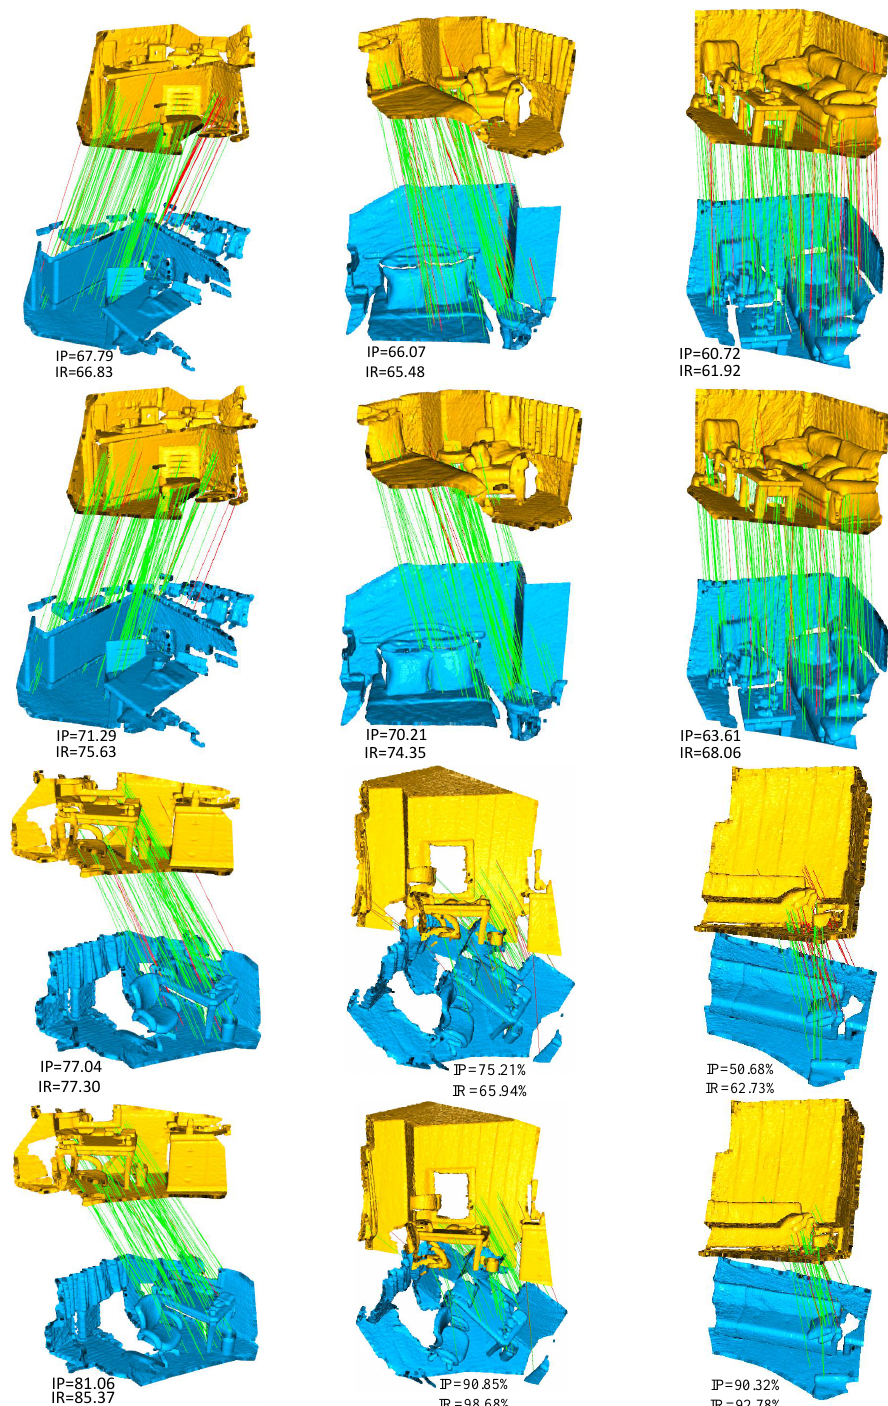
Figure 7. Visualization results for PointDSC (1, 3 rows) and CSCE-Net (2, 4 rows). These six scenes are the result of the 3DMatch dataset. The left side of each scene represents PointDSC and the right side represents CSCE-Net. The green lines indicate the identified correct matches (inliers) of the network, while the red lines indicate the preserved false matches (outliers) of the network. Inlier Precision ( IP ) and Inlier Recall ( IR ) are reported at the lower-left corner of each pair of point clouds. Best viewed with magnification and